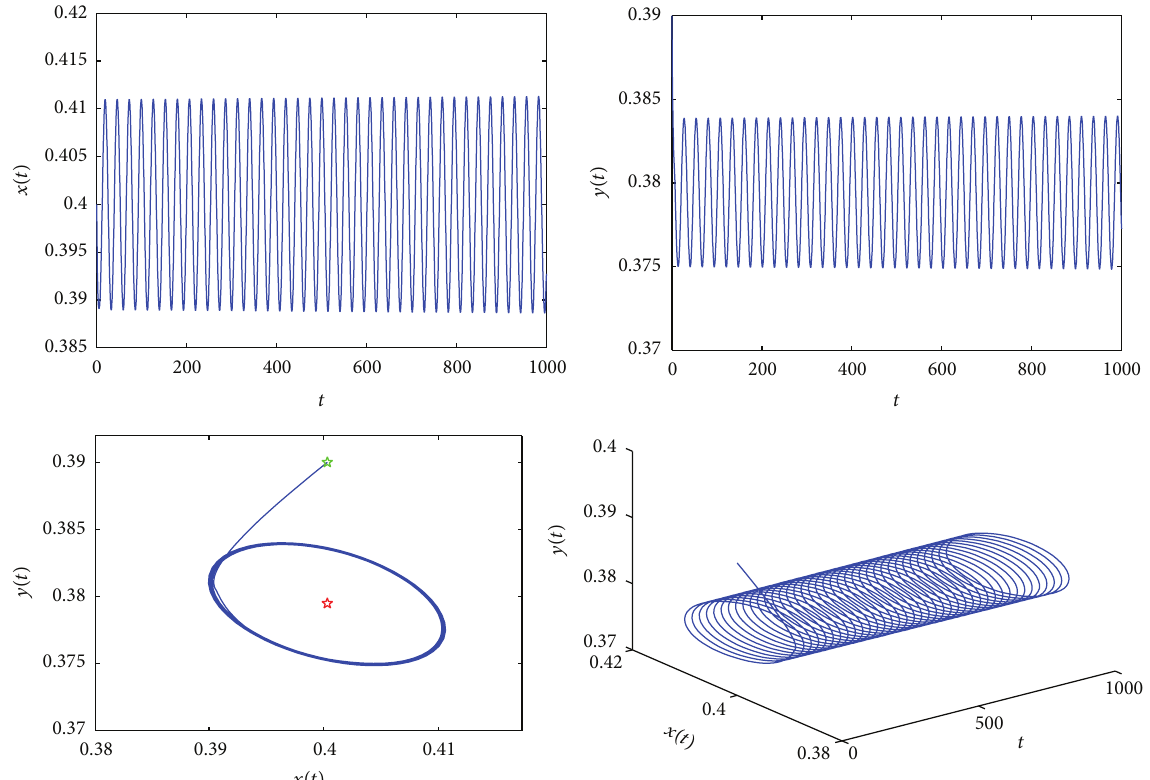
Figure 3: The trajectories and phase portrait of system (5). Initial values 𝑥 0 = 0.4 , 𝑦 0 = 0.39 . Parameters 𝑠 = 1 , 𝑐 = 0.6 . Delay value 𝜏 = 6.049